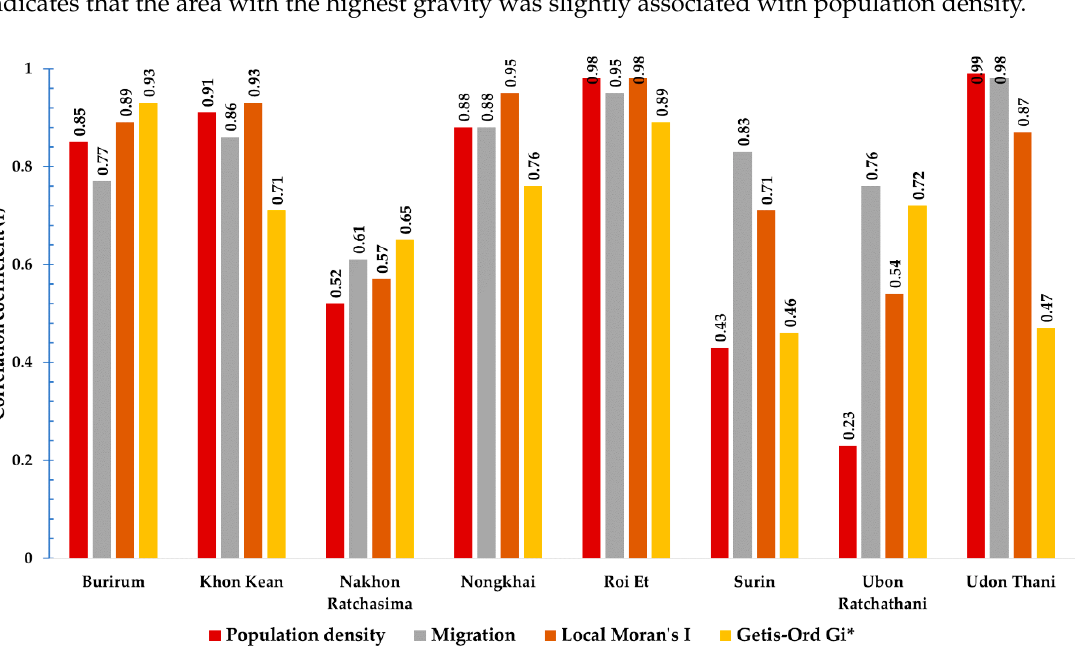
ffi cient of gravity index and related Figure 6 . Correlation coefficient of gravity index and related factors. Figure 6. Correlation coe